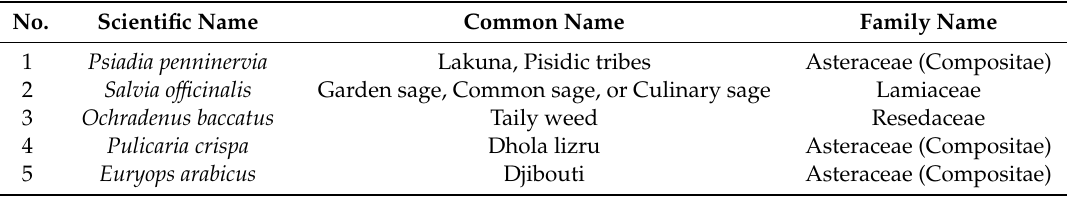
Table 1. The five medicinal plants used in the present